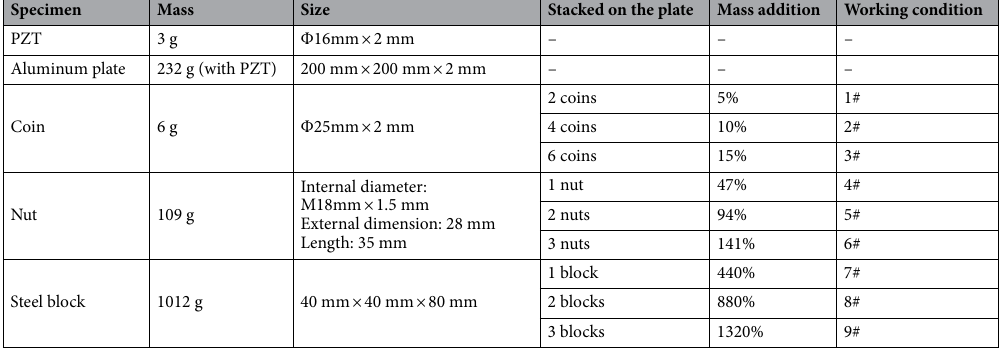
Table 2. Size and mass of experimental devices.